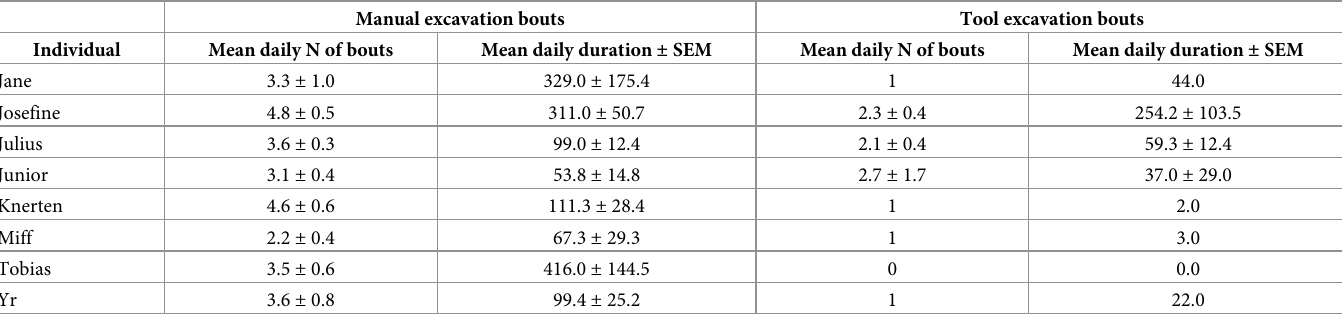
Table 4. Mean daily individual bout counts ± SEM and mean daily bout durations in seconds ± SEM of manual and tool excavating bouts. The data correspond to the observations made during the Compacted Soil Condition of Experiment 2.